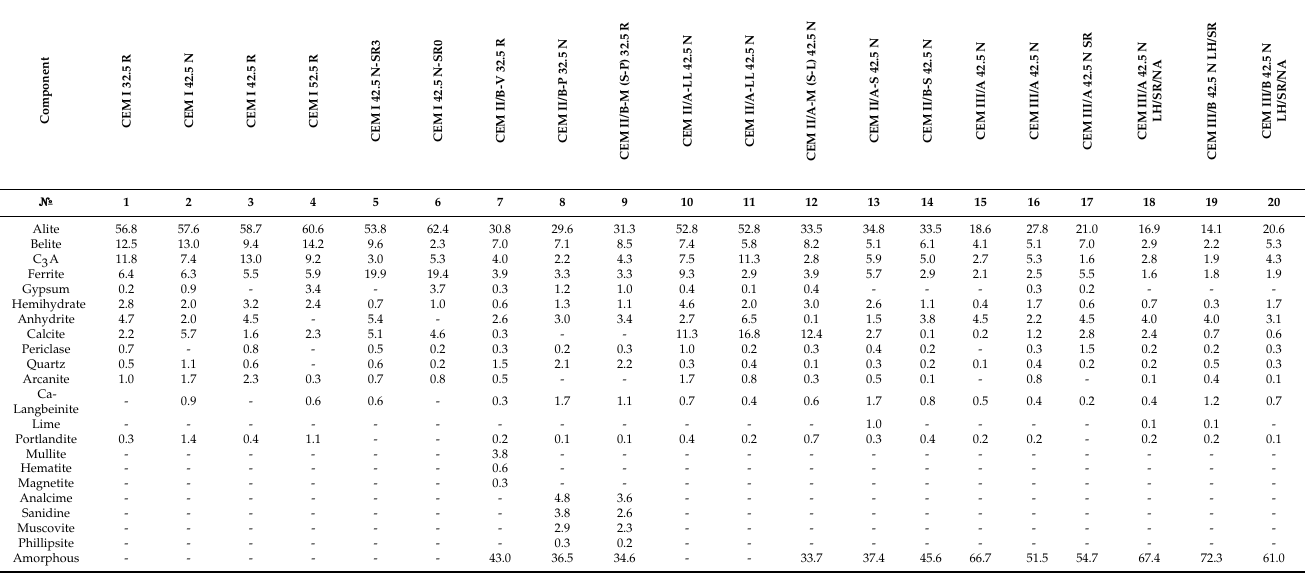
Table 4. Mineralogical composition of the cements (in wt%).